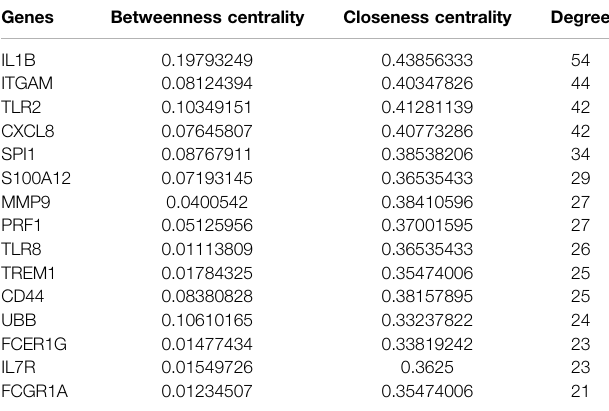
TABLE5| Top15hubgeneswithhighdegreesofconnectivityinpatientswithKD.